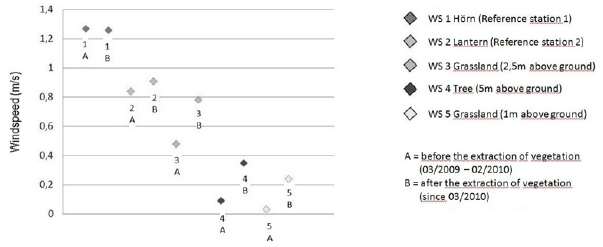
Figure 7. Average wind speed at di ff erent weather stations after the extraction of vegetation during periods with westerly winds at the reference station Aachen-H¨orn (1) and a wind speed between 1 and 1.5ms − 1 as a precondition for the existence of cold air drainage flow at the suburban valley stations